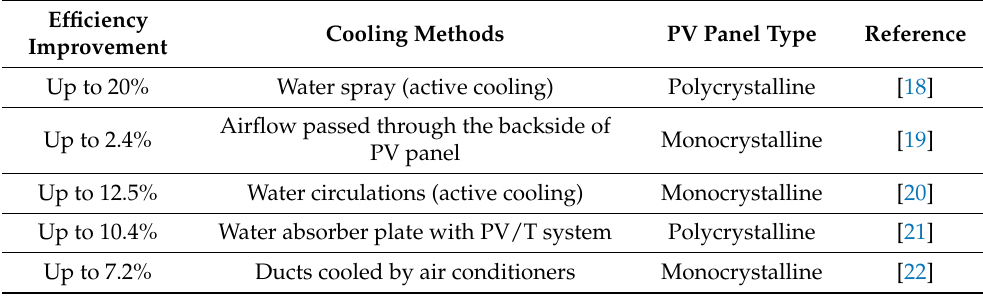
Table 1. The main cooling techniques investigated to reduce heat from solar